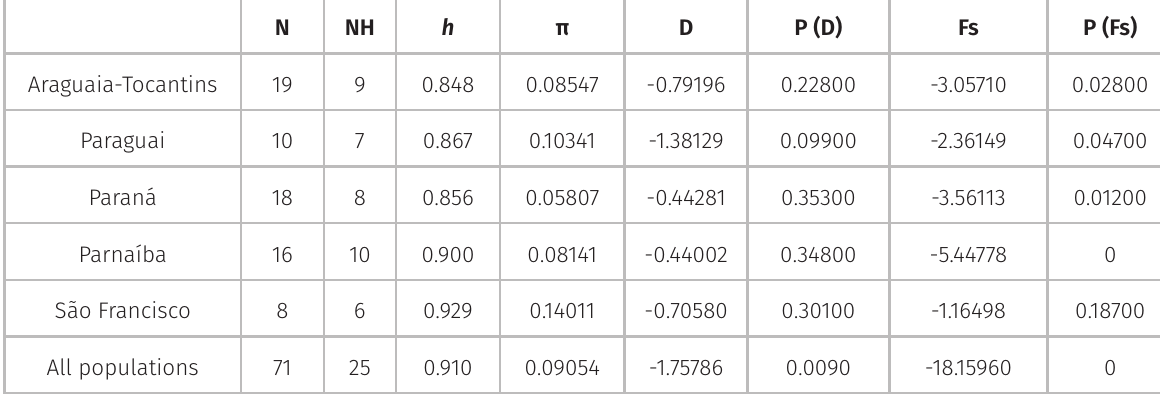
Table III. Summary of genetic diversity and neutrality tests to assess changes in the population size of Antilophia galeata in the Cerrado. The samples were grouped to observe the diversity of populations as a single evolutionary unit and also populations within the gallery forests present in the river basins. N NH h π D P (D) Fs P